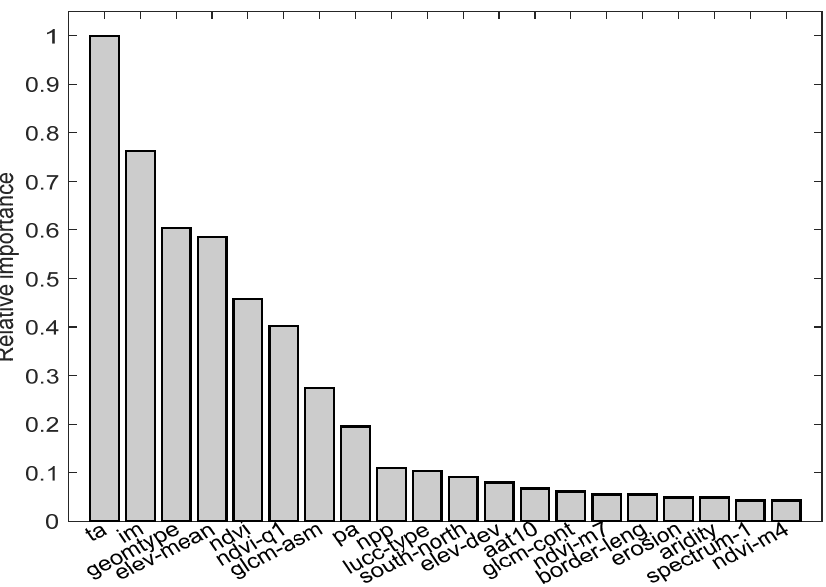
Figure 12. The relative importance of the top 20 significant environmental variables extracted from the RF model (1. ta: annual temperature; 2. im: wetness index; 3. geotype: geomorphological type; 4. elev-mean: mean value of elevation; 5. ndvi: normalized difference vegetation index (NDVI) from GF-2 data; 6. ndvi_q1: average value of NDVI in the first quarter from SPOT-4 data; 7. glcm_asm: angular second moment of a GLCM from GF-2 data; 8. pa: annual rainfall; 9. npp: net primary productivity; 10. lucc-type: land cover type; 11. south-north: south or north slope; 12. elev-dev: standard deviation value of elevation; 13. aat10: annual accumulated temperature; 14. glcm-cont: contrast of a GLCM from GF-2 data; 15. ndvi-m7: average value of NDVI in July from SPOT-4 data; 16. border-leng: border length of the polygon of geo-object; 17. erosion: soil erosion value; 18. aridity: dryness index; 19. spectrum-1: mean spectrum value of the first band from GF-2 data; 20. ndvi-m4: average value of NDVI in April from SPOT-4 data).